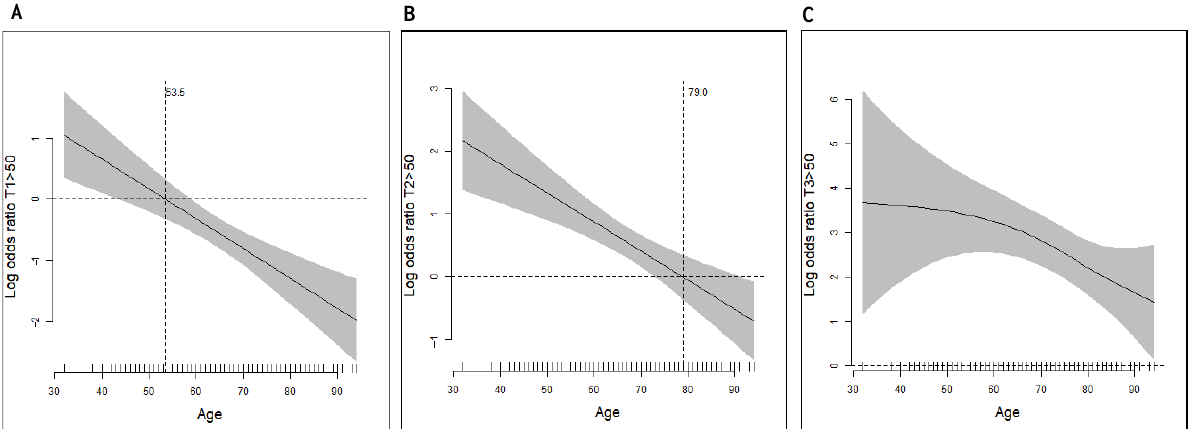
Figure 3. GAM plots show the negative association of the anti-RBD antibody responses with the age of the participants. ( A ) At T1, two weeks after the first dose of vaccine, participants with age less than 53.5 years had a positive odd ratio in developing positive anti-RBD antibody response. ( B ) At T2, ten weeks after the first dose of vaccine, participants with age less than 79.0 years had a positive odd ratio in developing positive anti-RBD antibody response. ( C ) At T3, four weeks after the second dose of vaccine, most participants across all age groups developed positive anti-RBD antibody response. Abbreviations: GAM, generalized additive models; RBD, receptor-binding